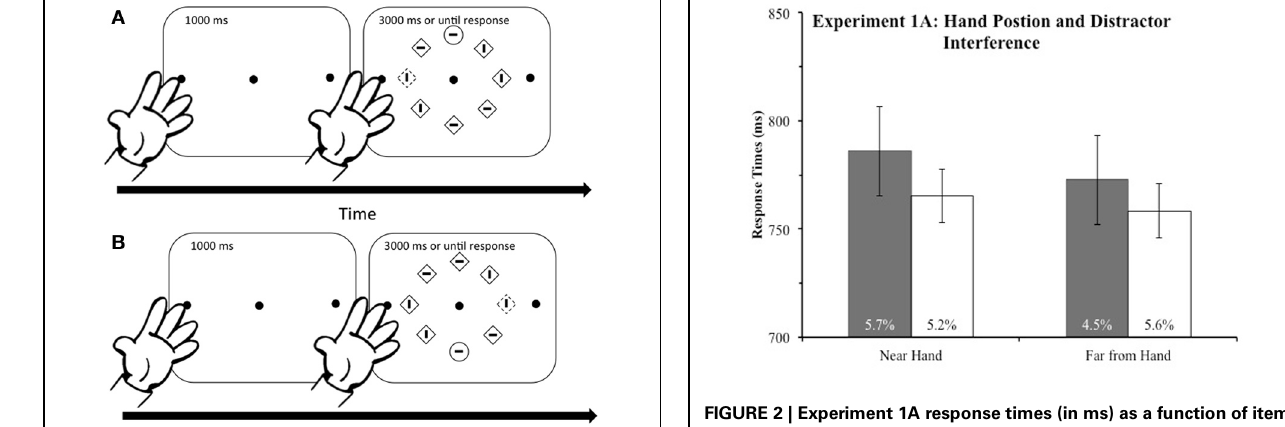
FIGURE 2 | Experiment 1A response times (in ms) as a function of item near hand (target or distractor) and distance from hand (near the hand or far from the hand). The error rates of each condition are reported in the base of the bars. Error bars represent 95% within-subject confidence intervals (Loftus and Masson, 1994).